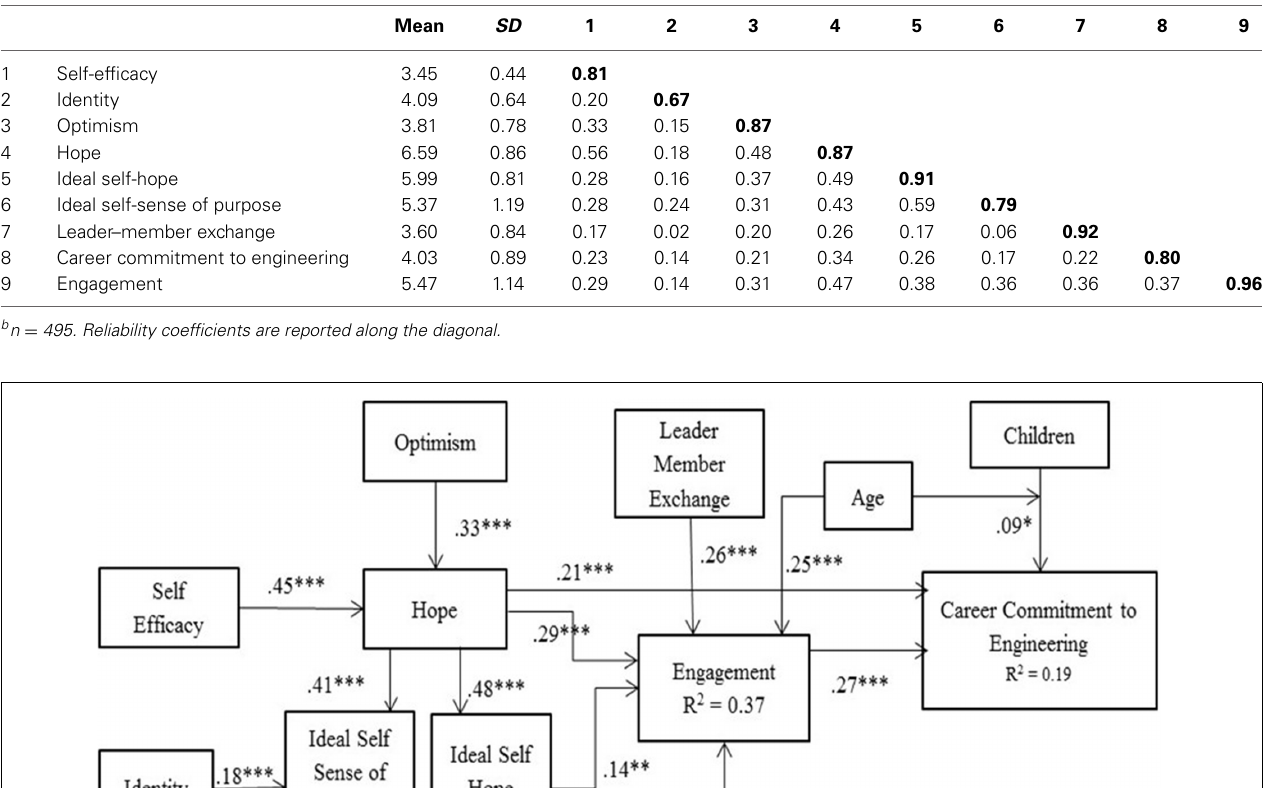
Table 2 | Means, standard deviations, cronbach’s alphas and correlations for the model variables b .